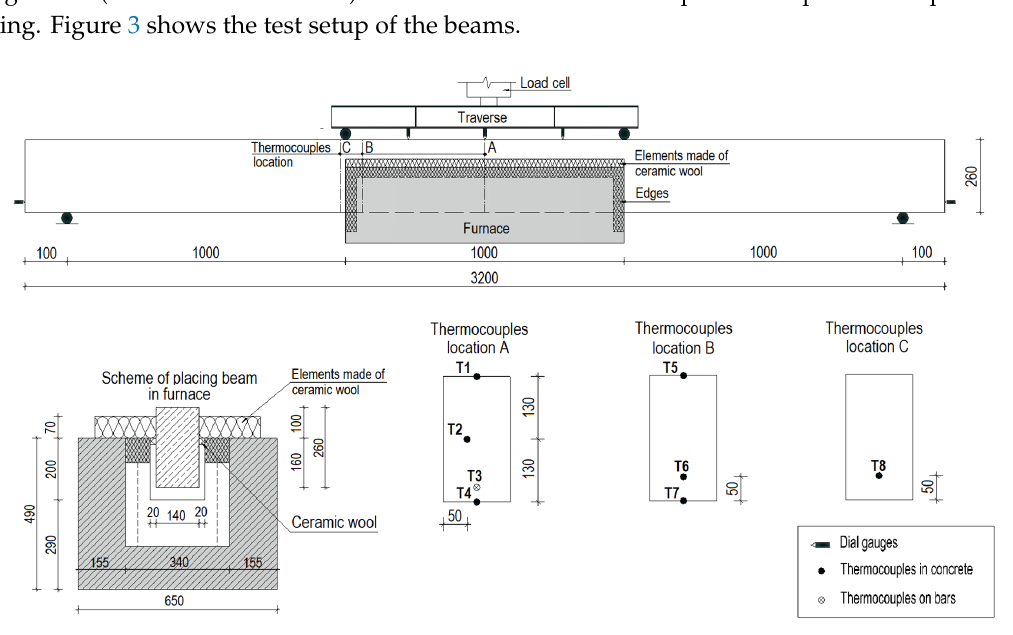
Figure 3. Test setup description.